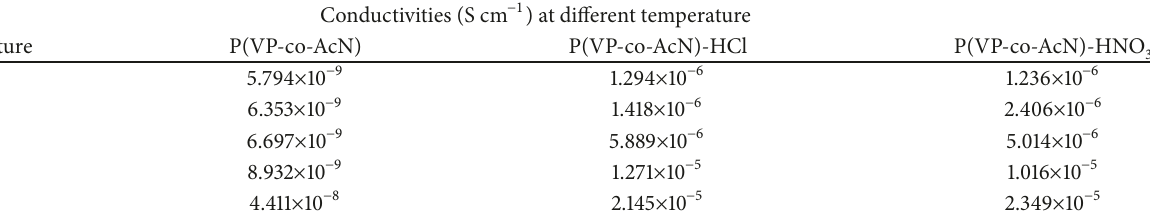
Figure 12: Photographic images showing the set-up for the contact of copolymer with acid fumes. Table 3: Temperature versus conductivity data.